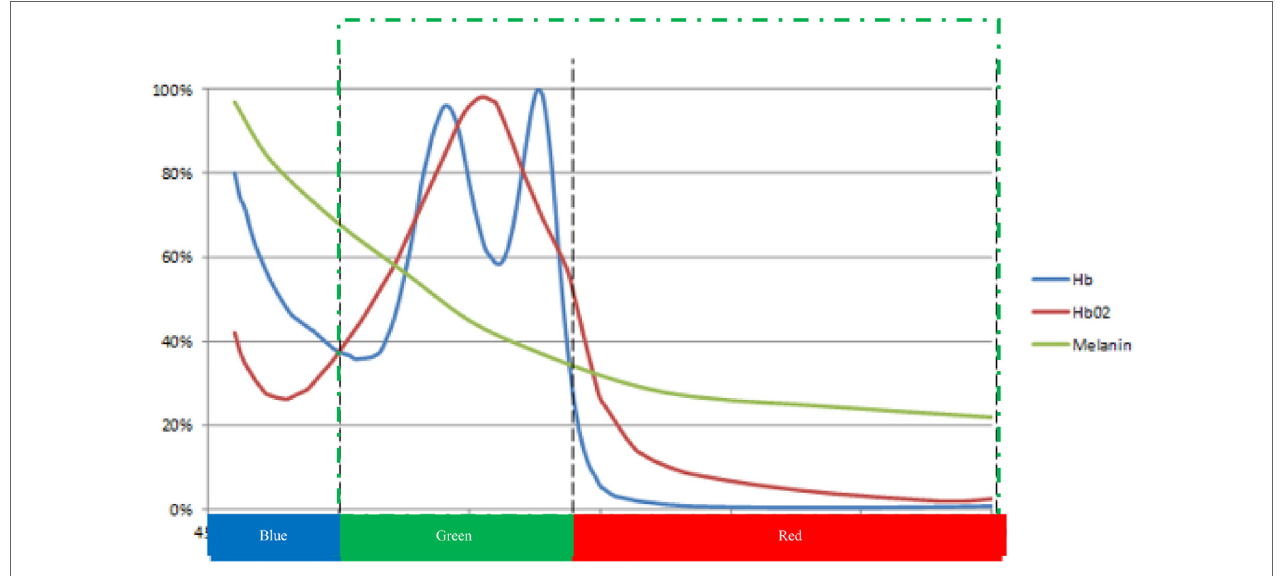
FigUre 1 | Schematic representation of the relative light absorption of the main chromophores of the human skin: Hb (deoxygenated hemoglobin), HbO 2 (oxygenated hemoglobin), and melanin. Bottom color bar: spectral response range for digital video cameras [adapted from Prahl (23) and Huang et al.